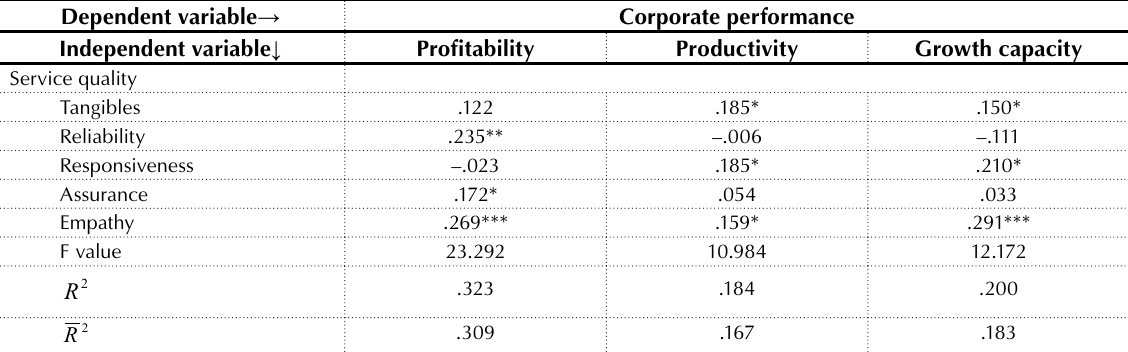
Data source: self-organized in this